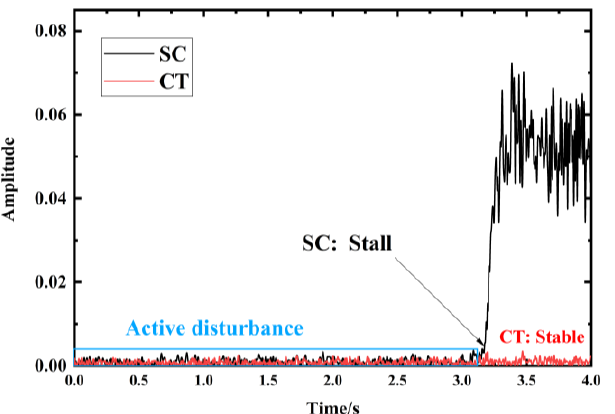
Figure 11. Development of C 1 amplitude in SC and CT when the compressor is slowly throttling to the stall point.